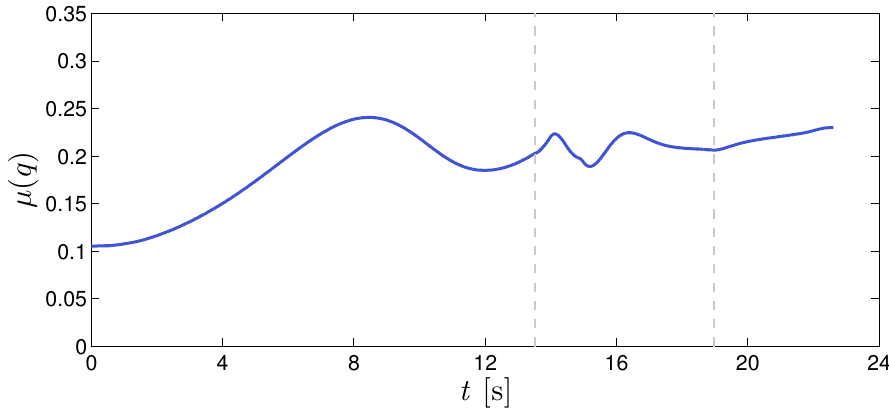
Figure 15. Changes of the manipulability measure.